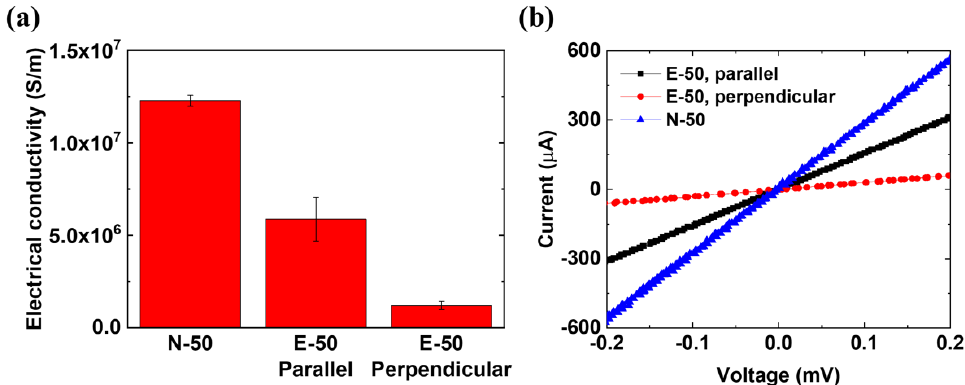
Figure 4. Electrical conductivity of the composites measured using the four-point probe method at room temperature. ( a ) Electrical conductivity values of a single 50-nm-thick Ag layer in N-50 and E-50. The electrical conductivity values of E-50 were obtained for two different directions, which are parallel and perpendicular to the nylon 66 NF alignment. ( b ) Corresponding I–V curves for the electrical conductivity measurements. The electrical conductivity of N-50 is significantly higher than those of the other samples because of the formation of well-connected electrical paths in the deposited Ag layer. As expected, there is no observed anisotropic characteristic depending on the direction for the electrical conductivity of N-50. On the other hand, the electrical conductivity of E-50 is relatively low because of the nanofibrous structure, and the conductivity in the parallel direction is higher than that in the perpendicular direction by a factor of 4.91.